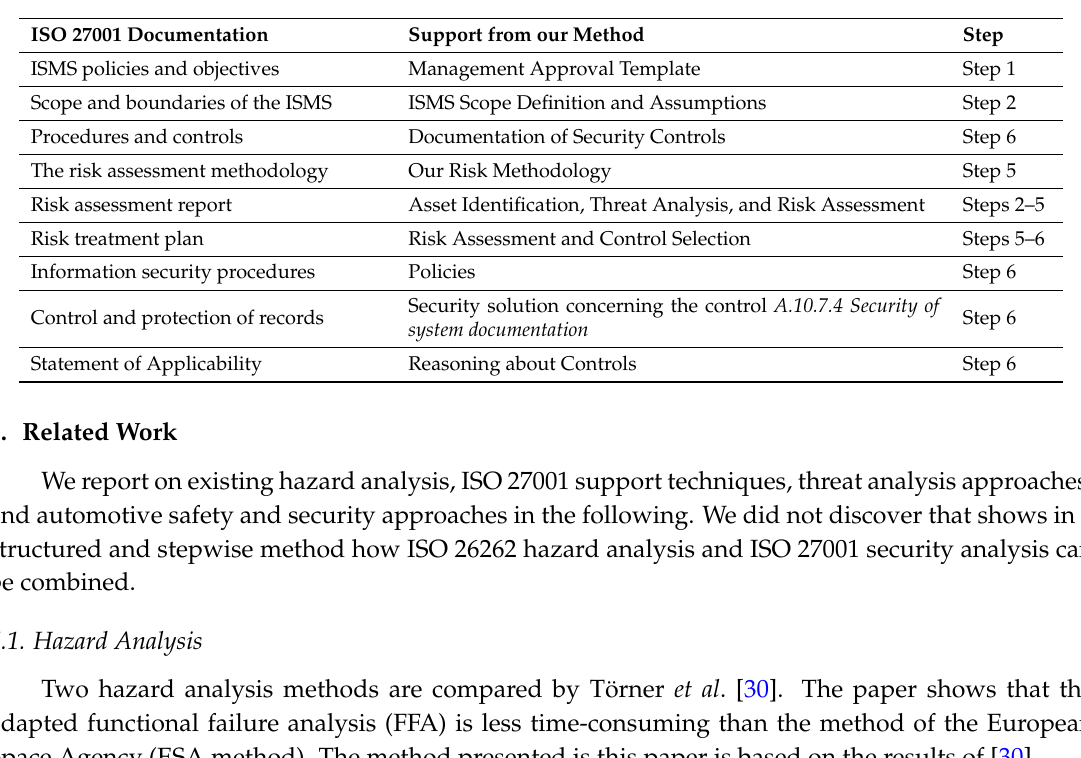
Table 17. Support of our Method for ISO 27001 Documentation